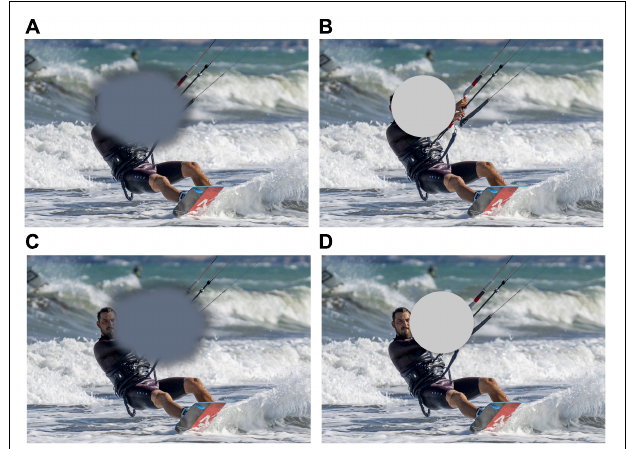
FIGURE 1 | (A) Typical representation of the visual field of a patient with central vision loss. In reality, patients with central vision loss are rarely aware of the location and extent of their scotoma, and, crucially, said scotoma does not present clear-cut borders as it is the case of the artificial scotoma, which is shown in panel (B) . A typical compensatory strategy in patients with central vision loss is the development of a peripheral retinal locus, or PRL, an eccentric fixation region close to the border of the scotoma, that patients use to fixate and solve demanding visual tasks, i.e., face recognition. Panel (C) shows where the scotoma might be placed to allow the face in the image to fall outside the scotoma and on the PRL. Panel (D) shows placement of a simulated scotoma allowing the face to be visible. Note once more that the hard edges of the simulated scotoma are different from the true scotoma, and may contribute to speeded development of a PRL with this paradigm (Walsh and Liu,